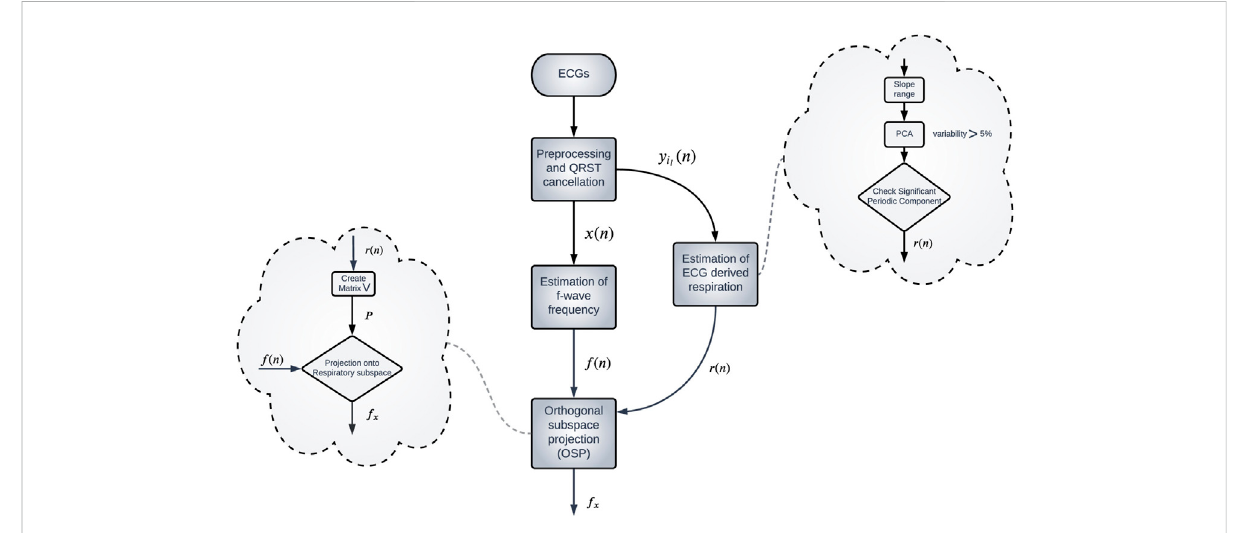
FIGURE 1 Schematic representation of the methodology.